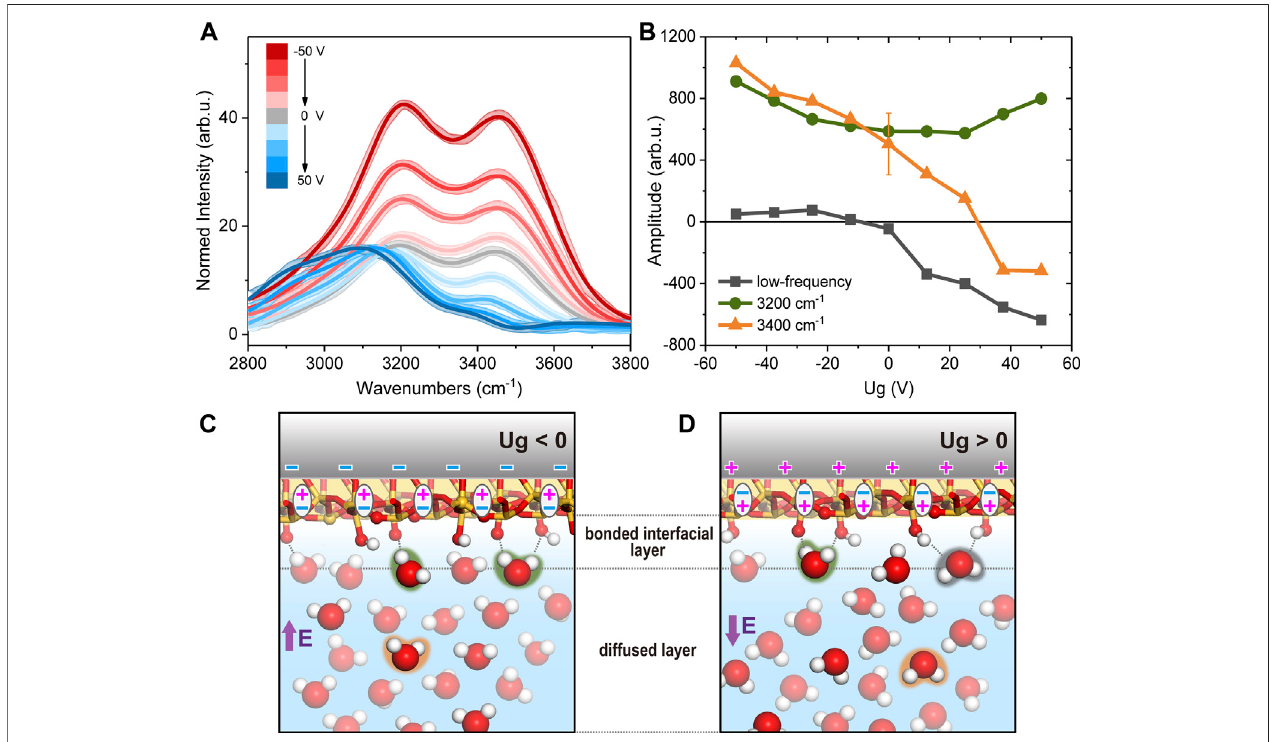
FIGURE 2 | (A) Normalized SFVS spectra in H 2 O. Solid curves are fi ts. (B) Fitted amplitudes of the low frequency mode (black square), 3,200 cm − 1 (green circle) and 3,400 cm − 1 (orange triangle) modes. Sketches of the interfacial structures in H 2 O when (C) U g < 0 and (D) U g > 0 .